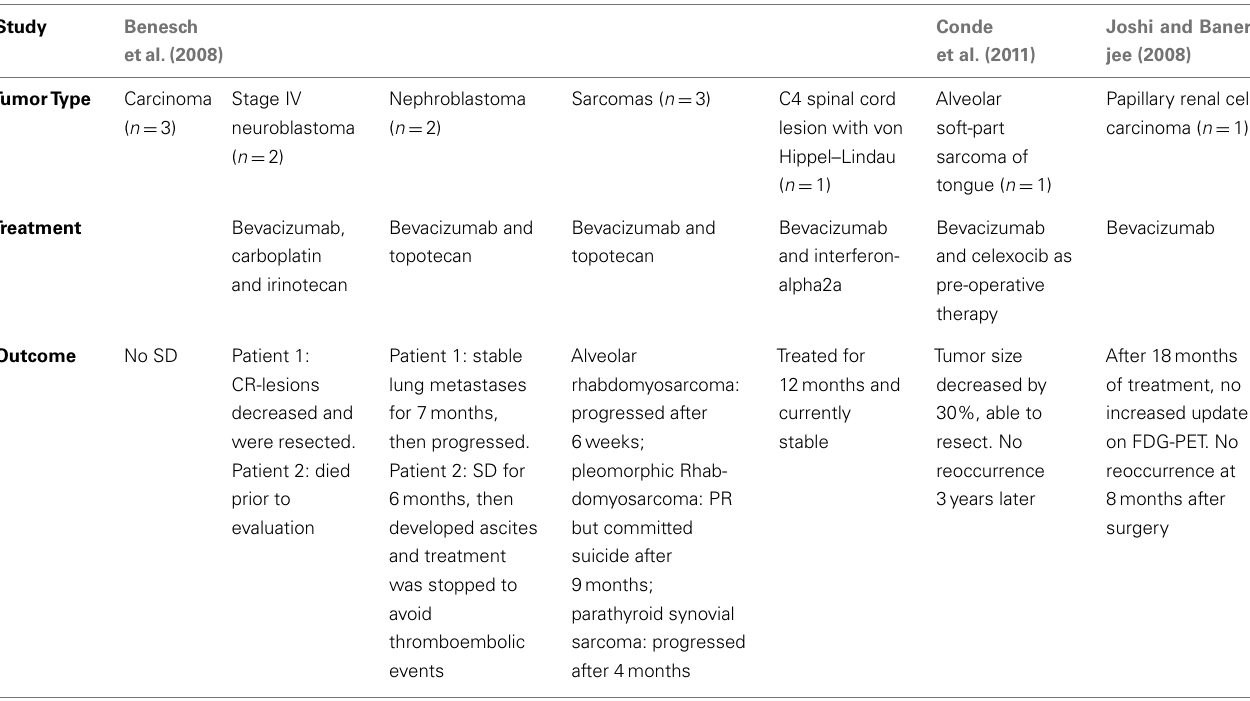
Table 3 | Efficacy results for non-CNS